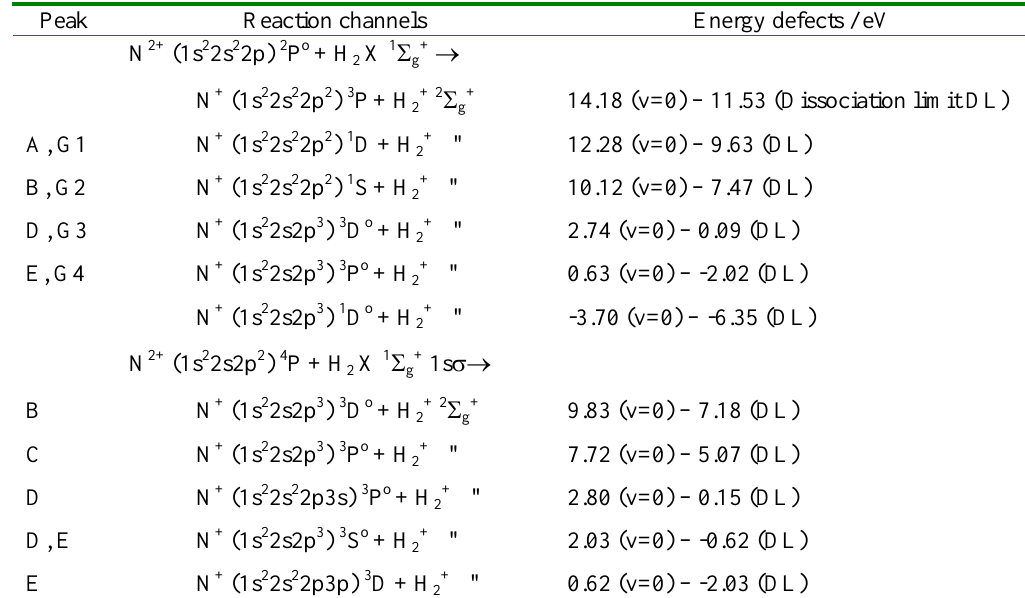
Table 1. Main reaction channels for electron capture by N 2+ ions in H Peak Reaction